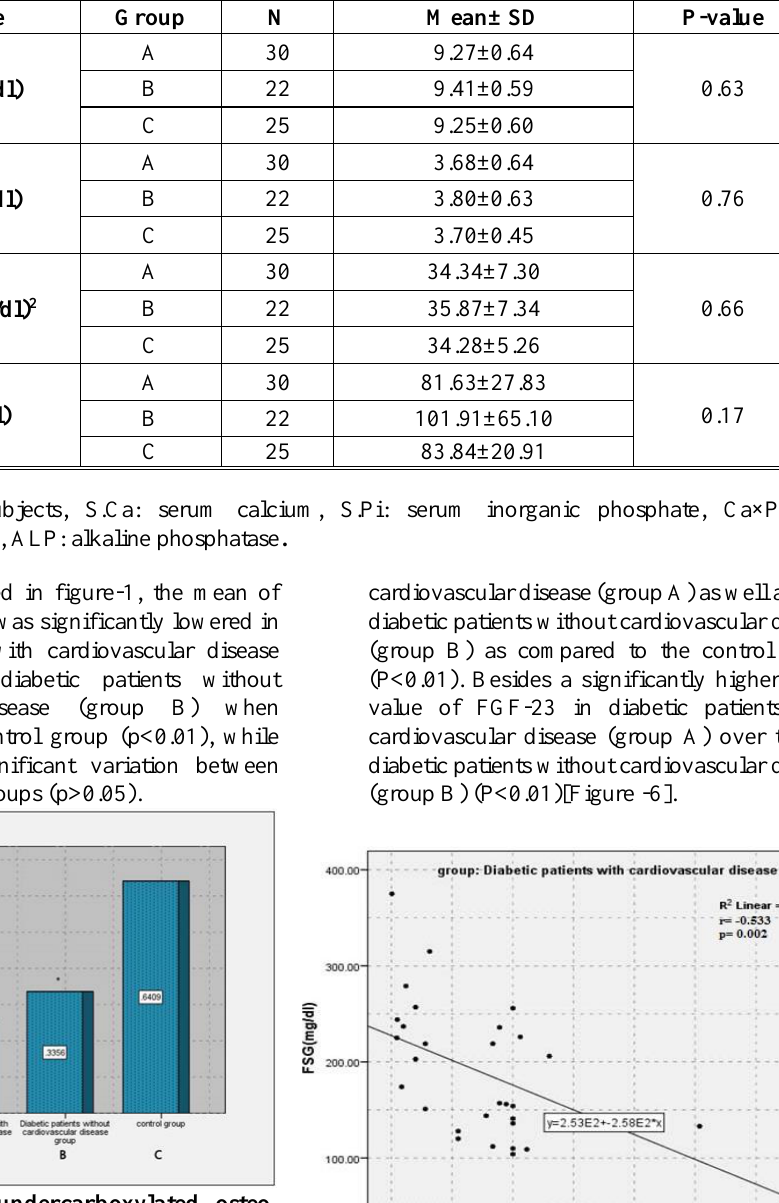
Figure1. Serum undercarboxylated osteo- calcin levels in diabetics and control groups.